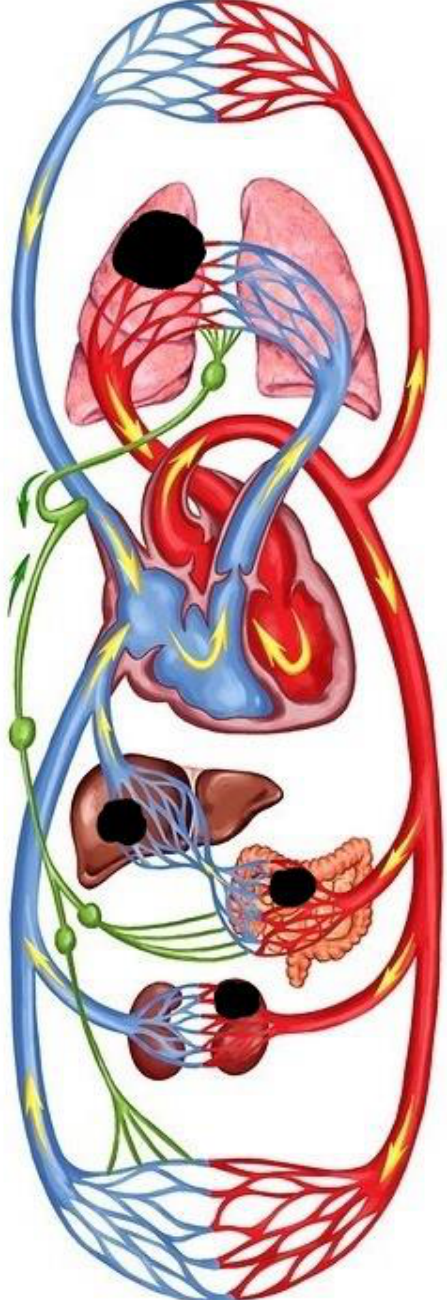
Figure 1. Schematic representation of the human circulatory system.